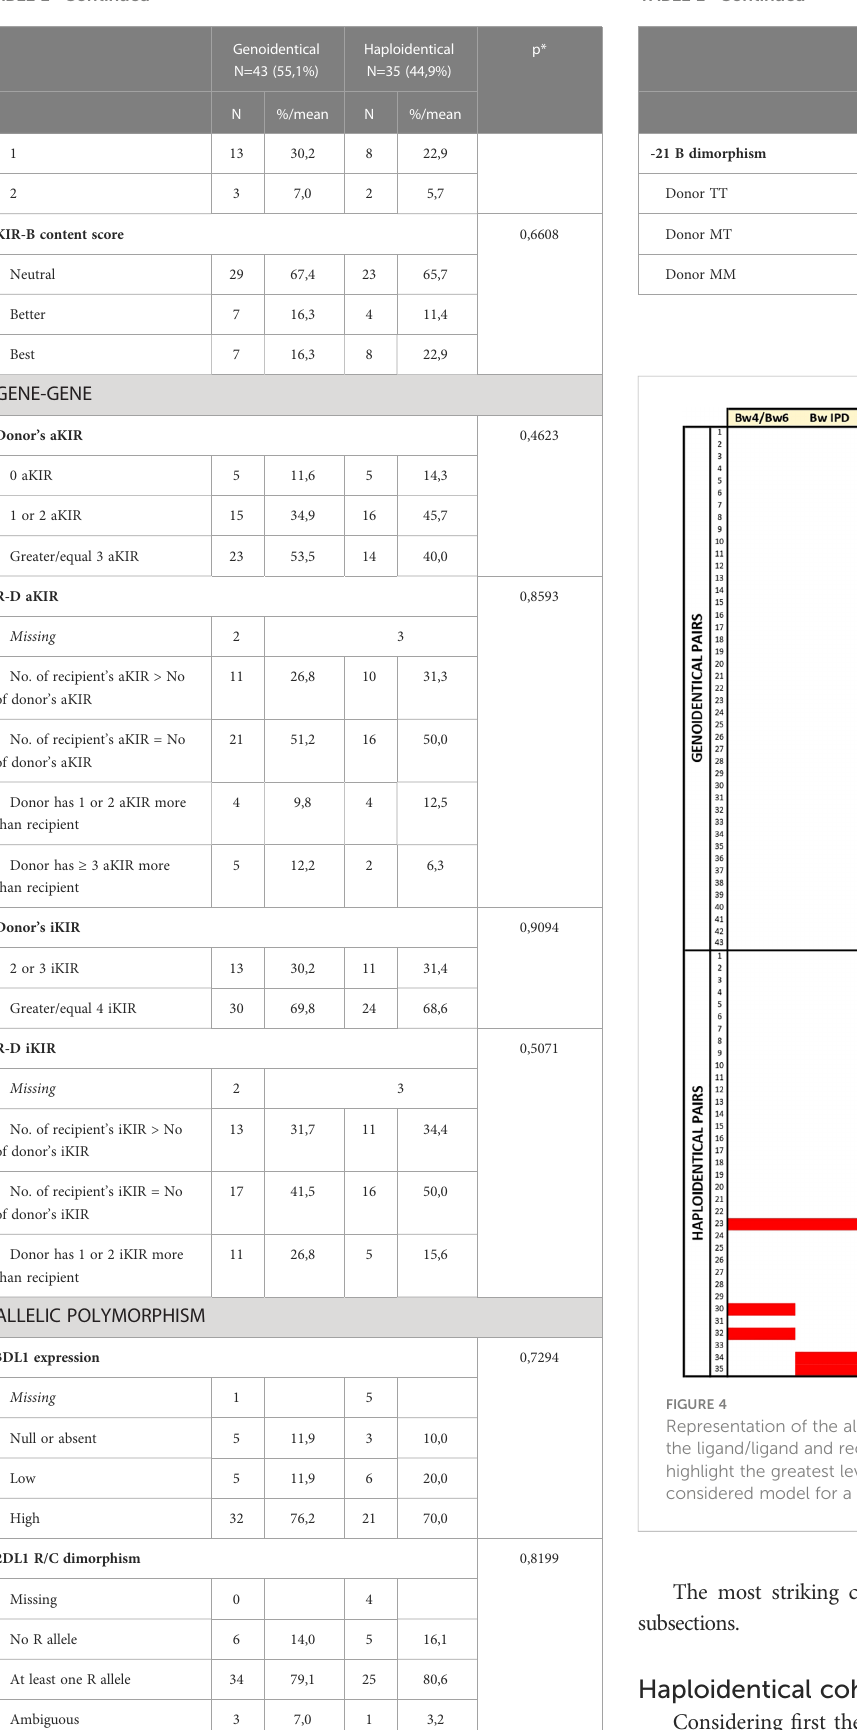
Haploidentical cohort Considering fi rst the KIR haplotype-based categories; (i) KIR-B content score highly correlates with the number of Cen-B but not Tel-